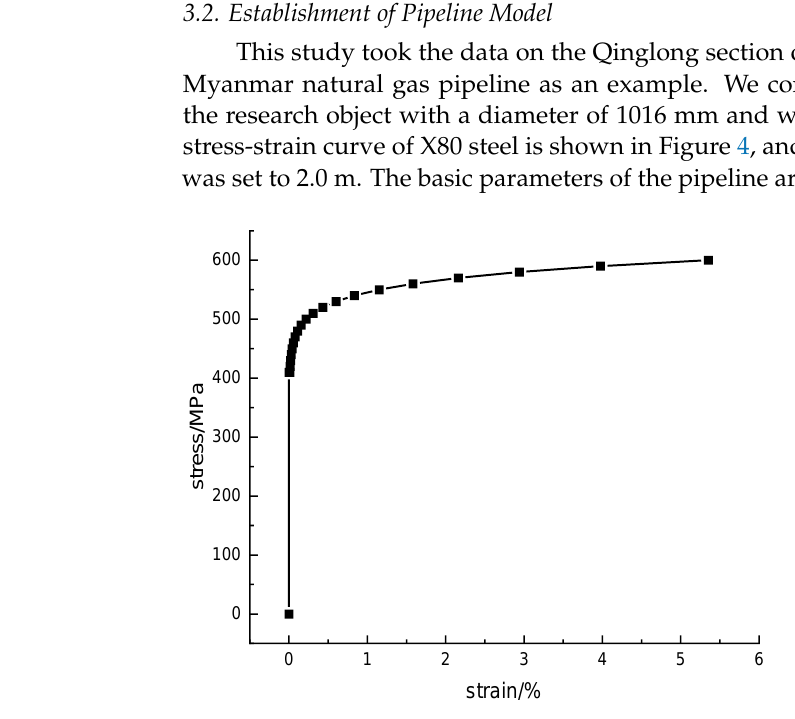
Figure 4. True stress–strain curve of X80 steel. Table 2. Basic parameters of pipeline model.